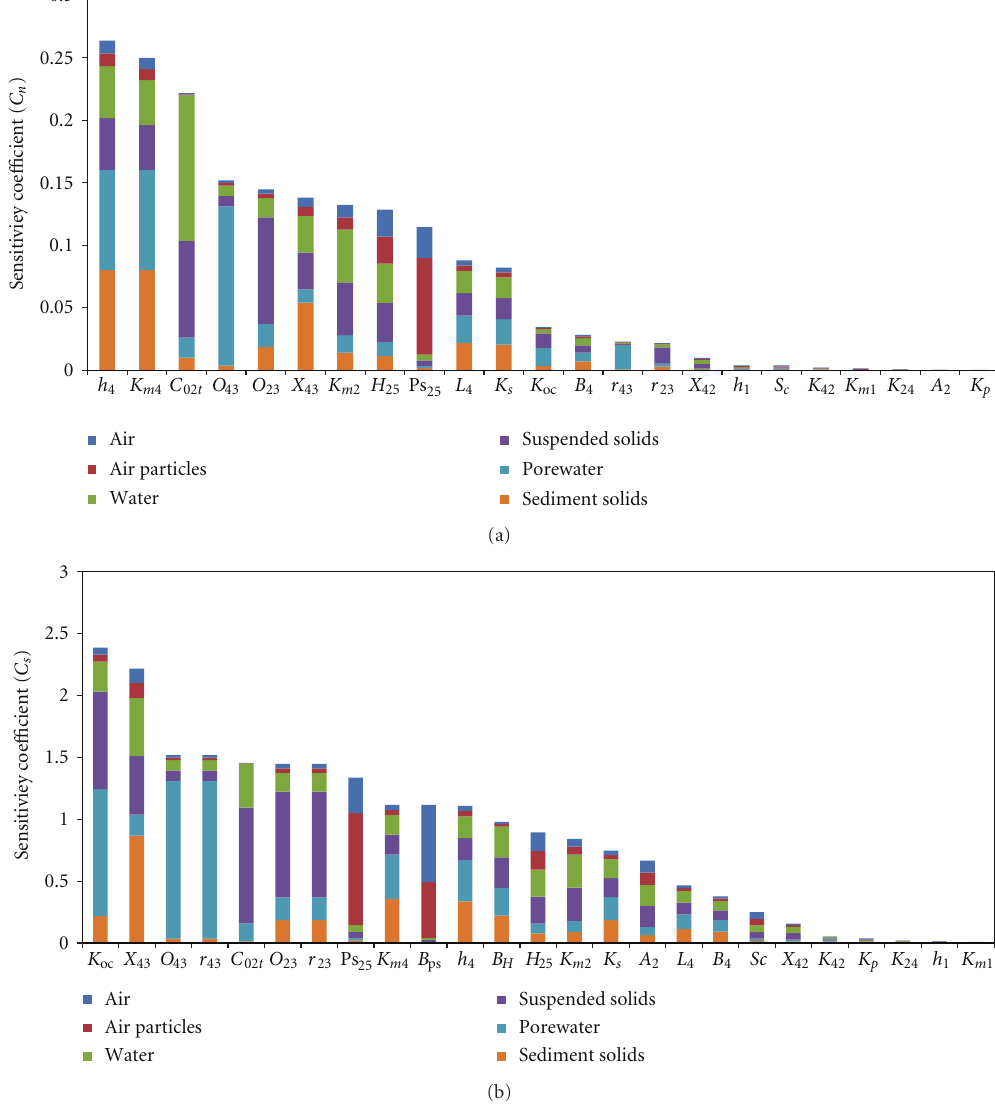
Figure 6: Coe ffi cients of sensitivity of the calculated concentrations of the environmental compartments to the input static parameters with ( C n ) (a) and without ( C s ) (b) CV